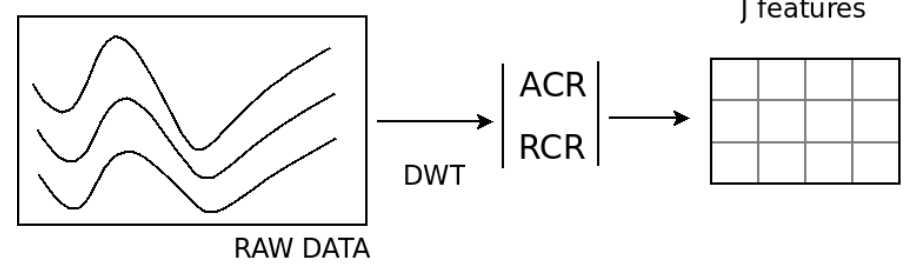
Figure 2. From curves to matrices.